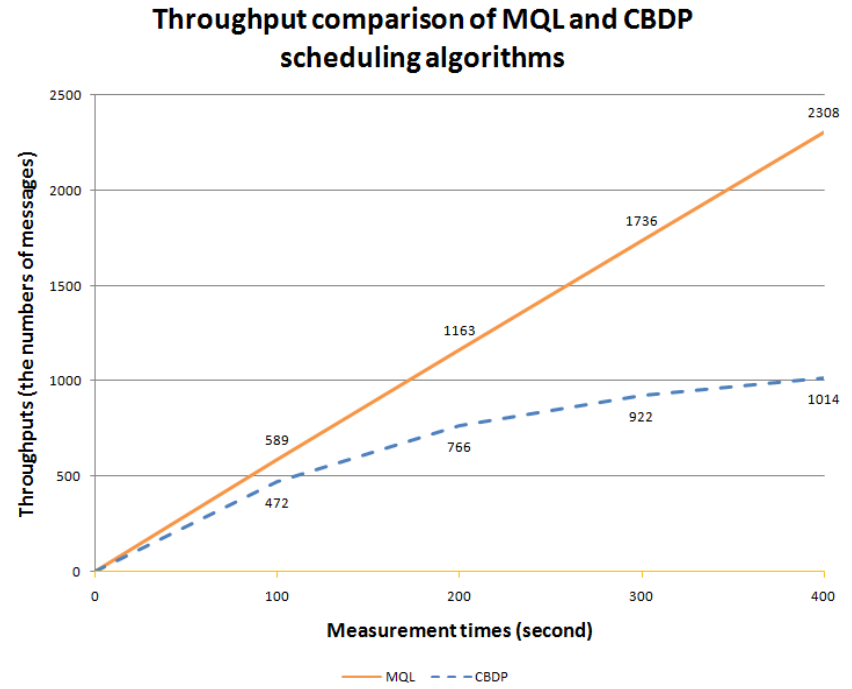
Figure 14. Throughputs of the MQL (Multiclass Q-learning) and the MBDP (Multiclass Based Dynamic Priority) scheduling algorithms. Priority) scheduling